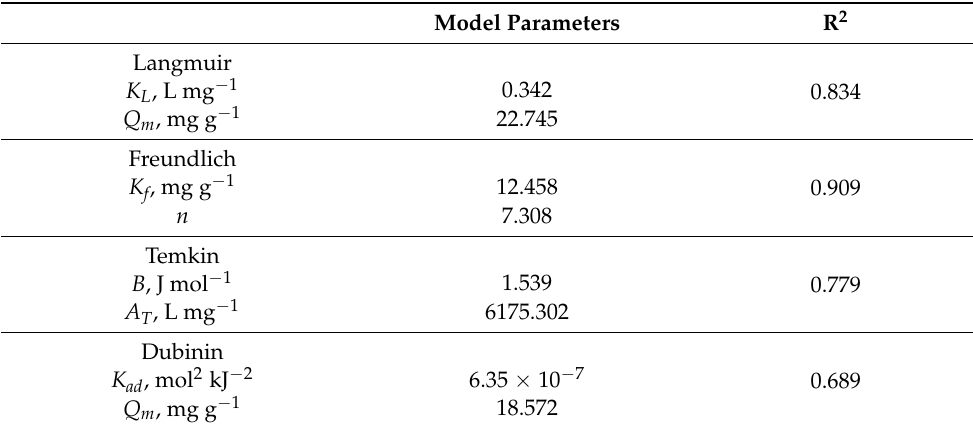
Table 4. Isotherm parameters for the adsorption of Cu (II) onto waste marble Table 5. Adsorption of Cu (II) on inorganic materials.